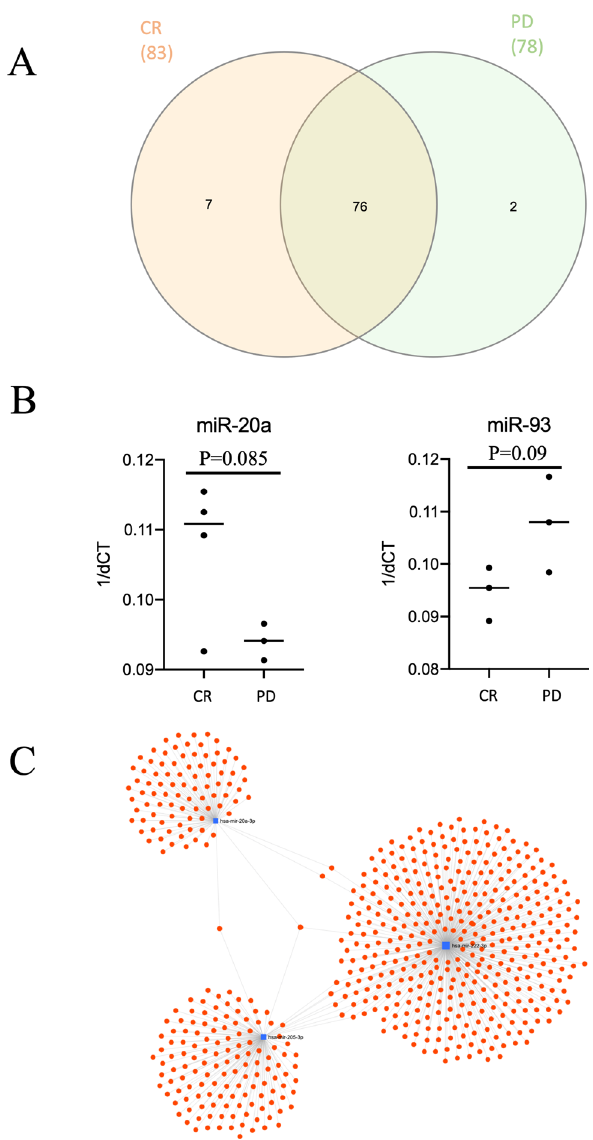
Figure 4. Screening of exosomal oncomirs revealed potential markers for clinical response. ( A ) Venn diagram of 85 oncomirs found to be expressed in SEVs. ( B ) Expression of mir-20a and mir-93 is significantly different between groups CR and PD. ( C ) Target genes from the oncomirs associated with complete response lymphoma patients. It is possible to notice few genes targeted for more than one